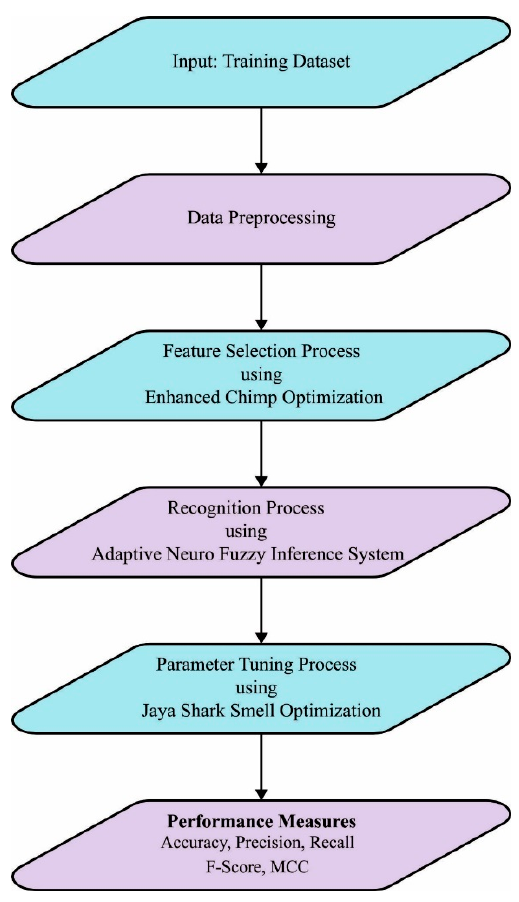
Figure 1. Workflow of IMFL-IDSCS system.